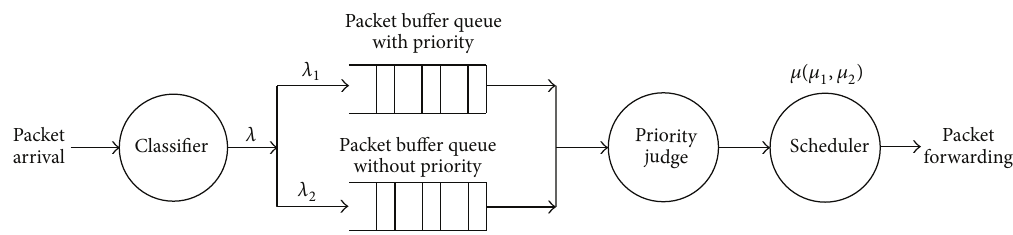
Figure 4: Data processing model for the queuing system with priority.